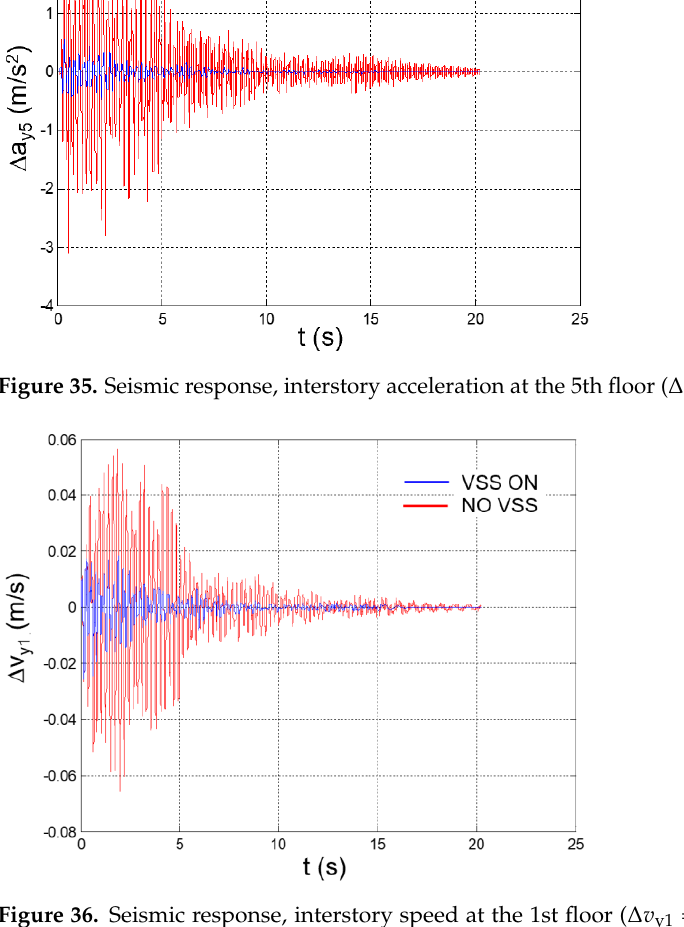
Figure 36. Seismic response, interstory speed at the 1st floor ( ∆ v y1 = v y1 : speed of Node 45 with respect to the ground).